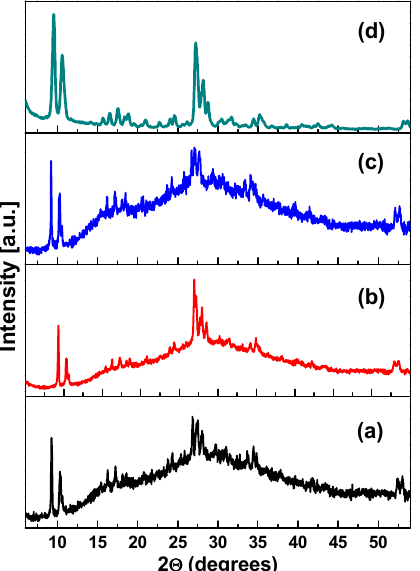
Figure 1. Powder X-ray di ff raction (XRD) patterns of the synthesized samples; ( a ) MFI-40, ( b ) MFI-45, ( c ) MFI-50, and ( d ) Zeolyst.